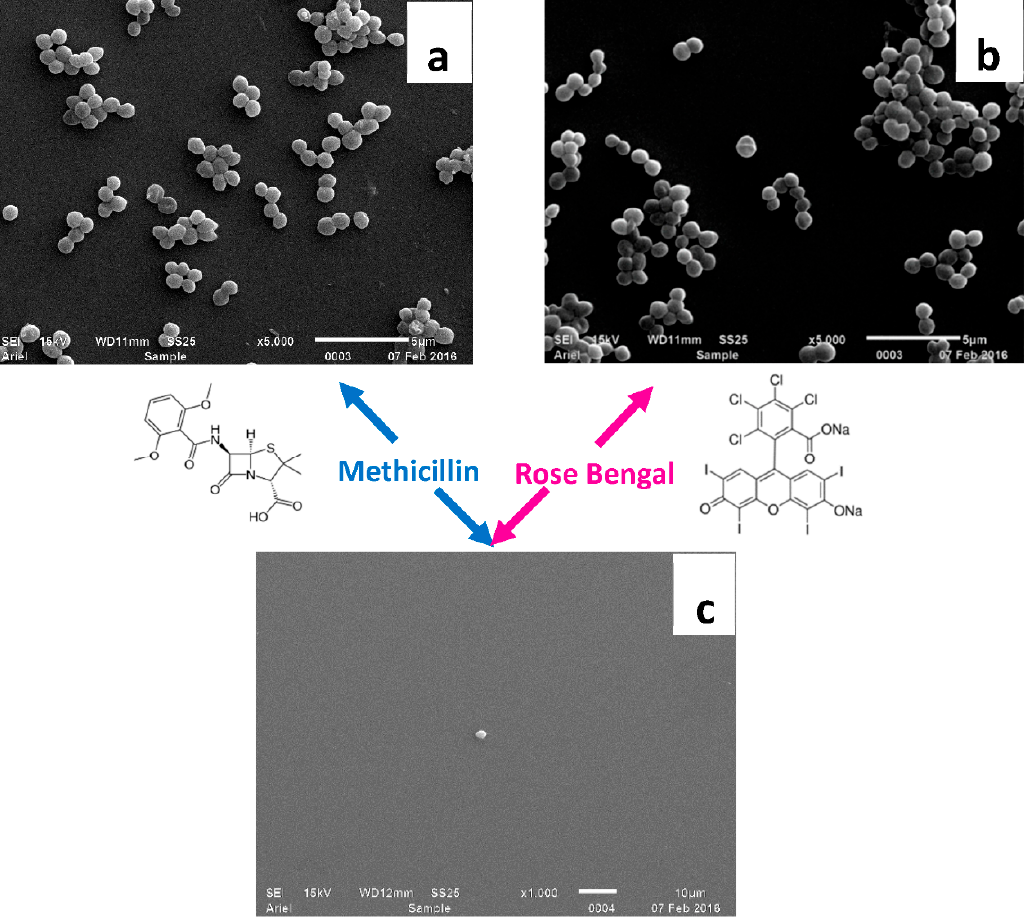
Figure 1. SEM micrographs of MRSA 69397 cells in the presence of 9.5 mg/L of methicillin ( a ), 0.625 mg/L of Rose Bengal ( b ) and 9.1 µ g/L of methicillin combined with 0.625 mg/L of Rose Bengal ( c ).